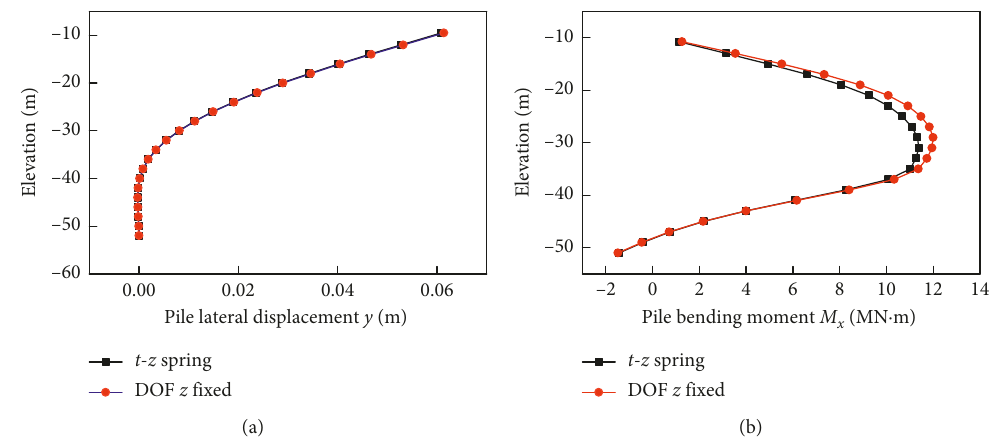
Figure 14:1 st row pile responses for different axial SPI considerations. (a) Pile lateral displacement y in the 5 th row. (b) Pile bending moment M x in the 5 th